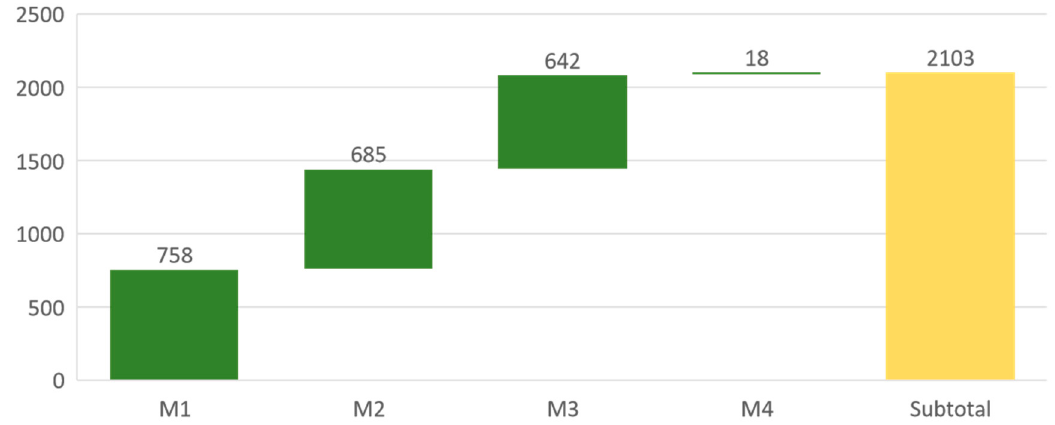
Figure 4. Health benefits of administrative pollution control measures (in billions of new Taiwan dollars (NTD)).